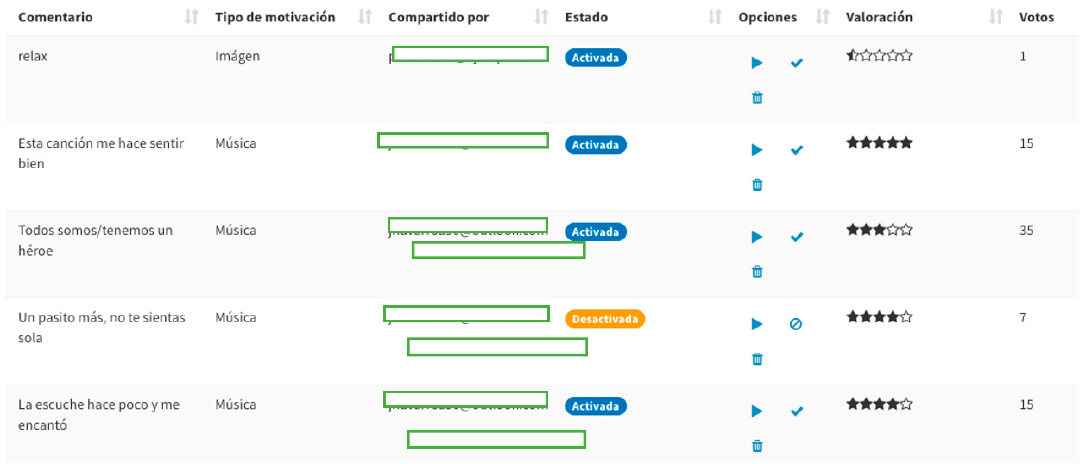
Figure 6. Screens of the web interface where the psychologists can see and manage the motivations.